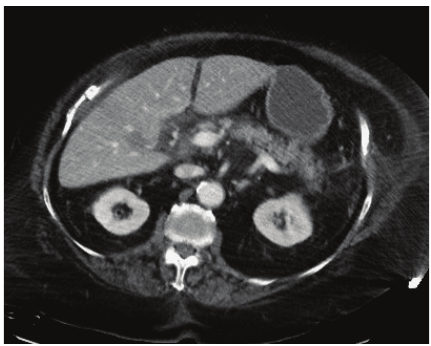
Figure 1: Axial CT image demonstrating inflammation of the head and body of the pancreas.